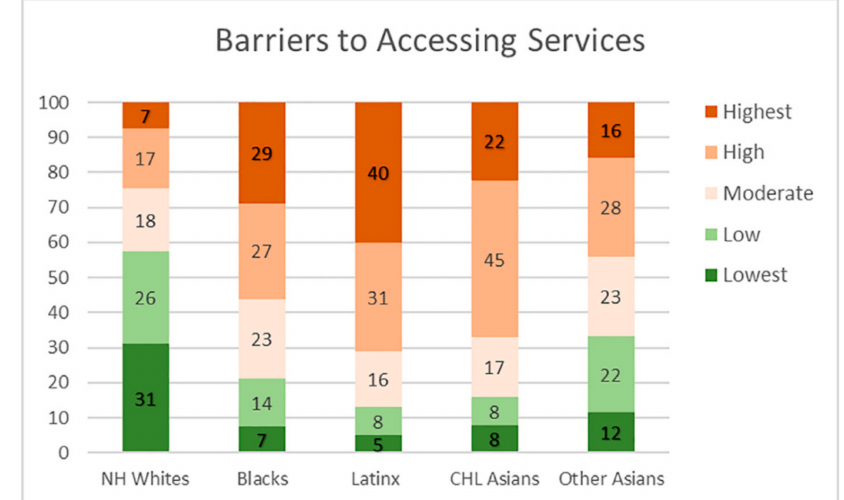
Figure 7. Ethnoracial distribution by neighborhood barriers to accessing health